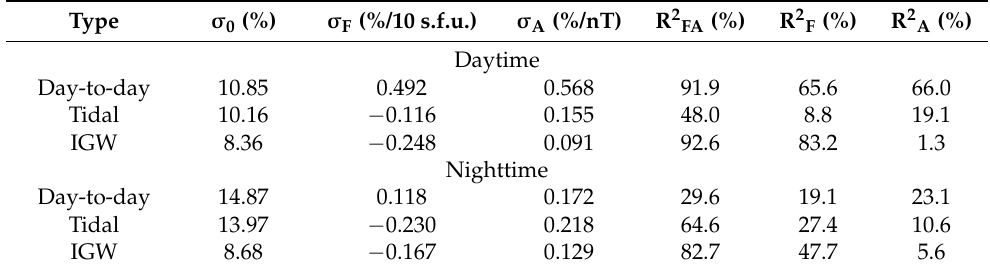
Table 1. Coefficients of multiple regression of σ NmF2 on F10.7 and Ap ( σ 0 , σ F , σ A ) and coefficients of determination for multiple (R 2FA ) and simple regressions (R 2F , R 2A ).